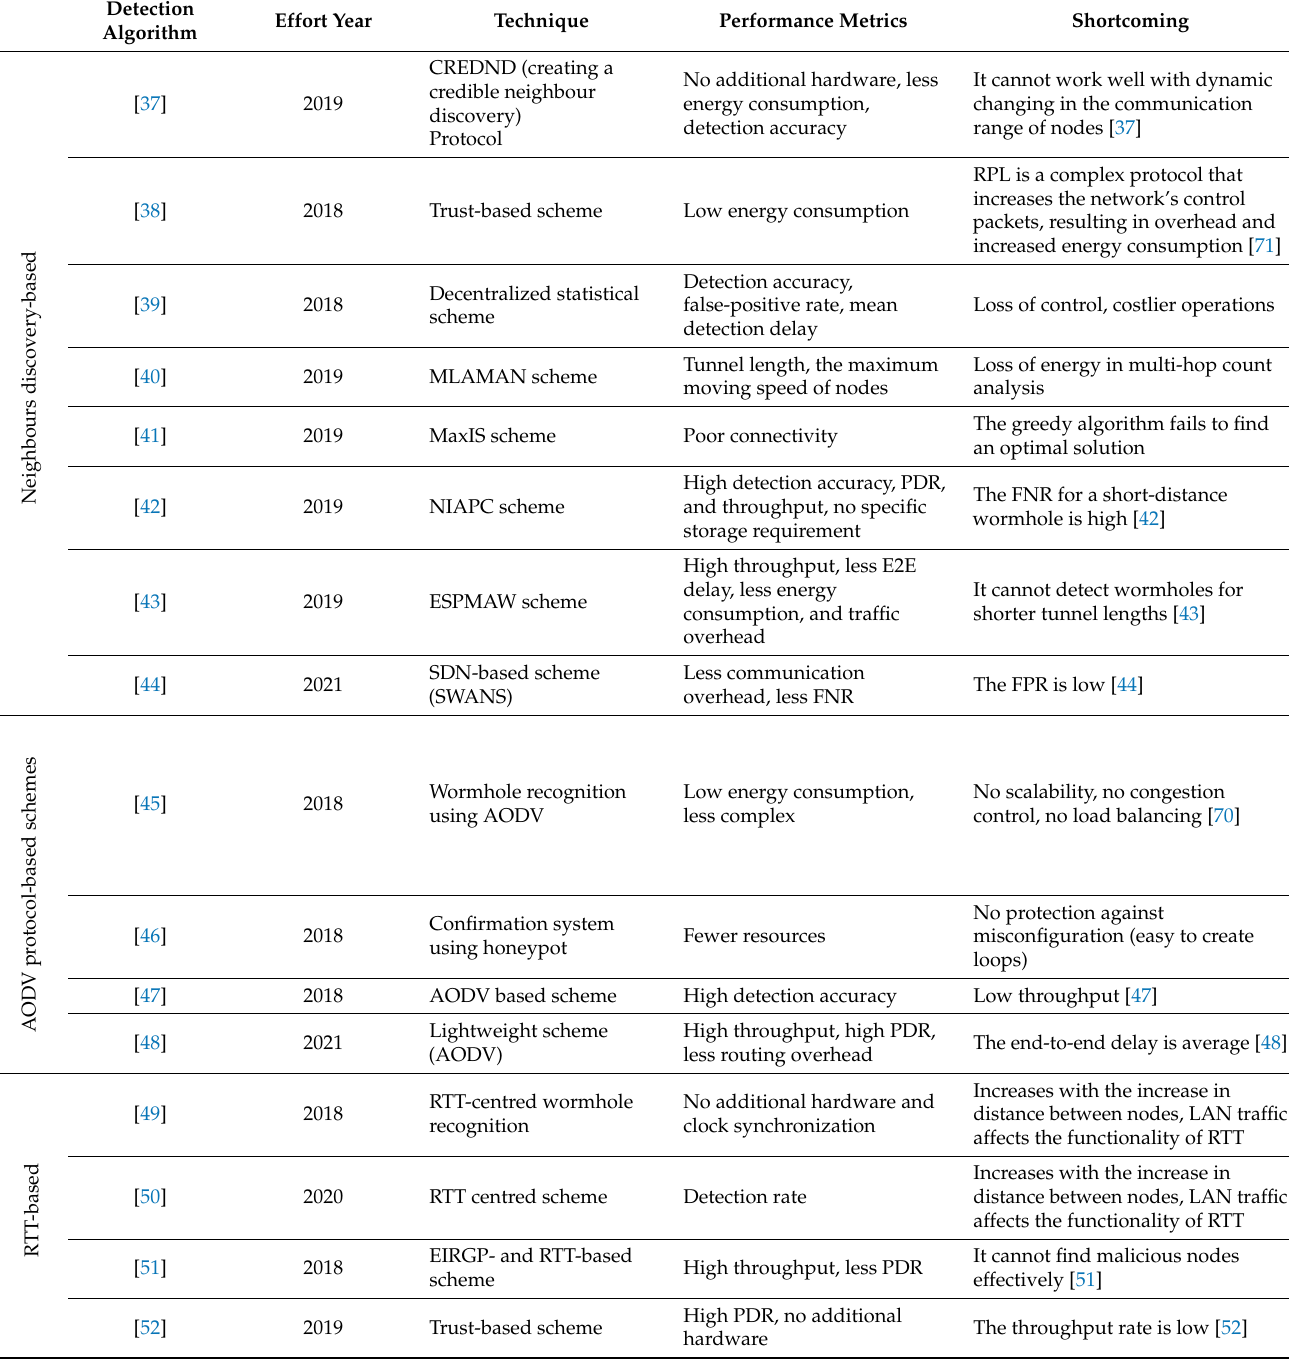
Table 5. Summary of critical analysis of wormhole detection schemes. Detection